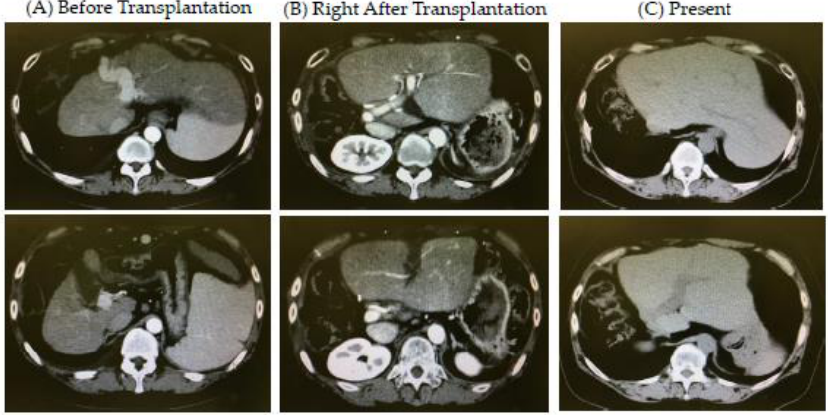
Figure 1. Computed tomography images before and after living-donor liver transplantation (LDLT): ( A ) before LDLT; ( B ) right after LDLT; and ( C ) present (about 8.5 years post-LDLT).